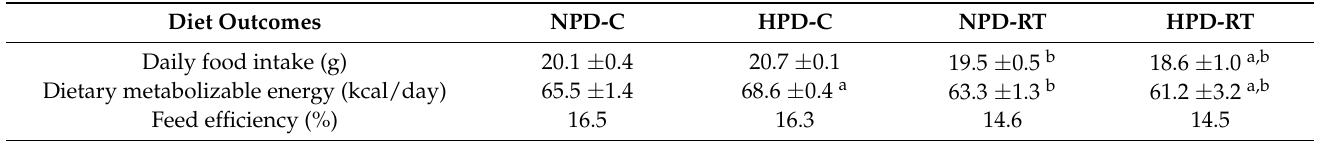
Table 1. Characteristics of diets concerning experimental